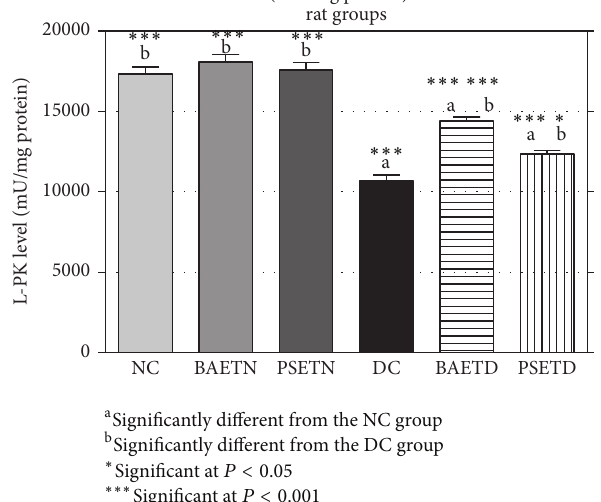
Figure 4: Effect of Balanites aegyptiaca fruits and Petroselinum sativum leaf aqueous extracts on the mean liver PK levels of normal and STZ-induced diabetic rats (mean ±